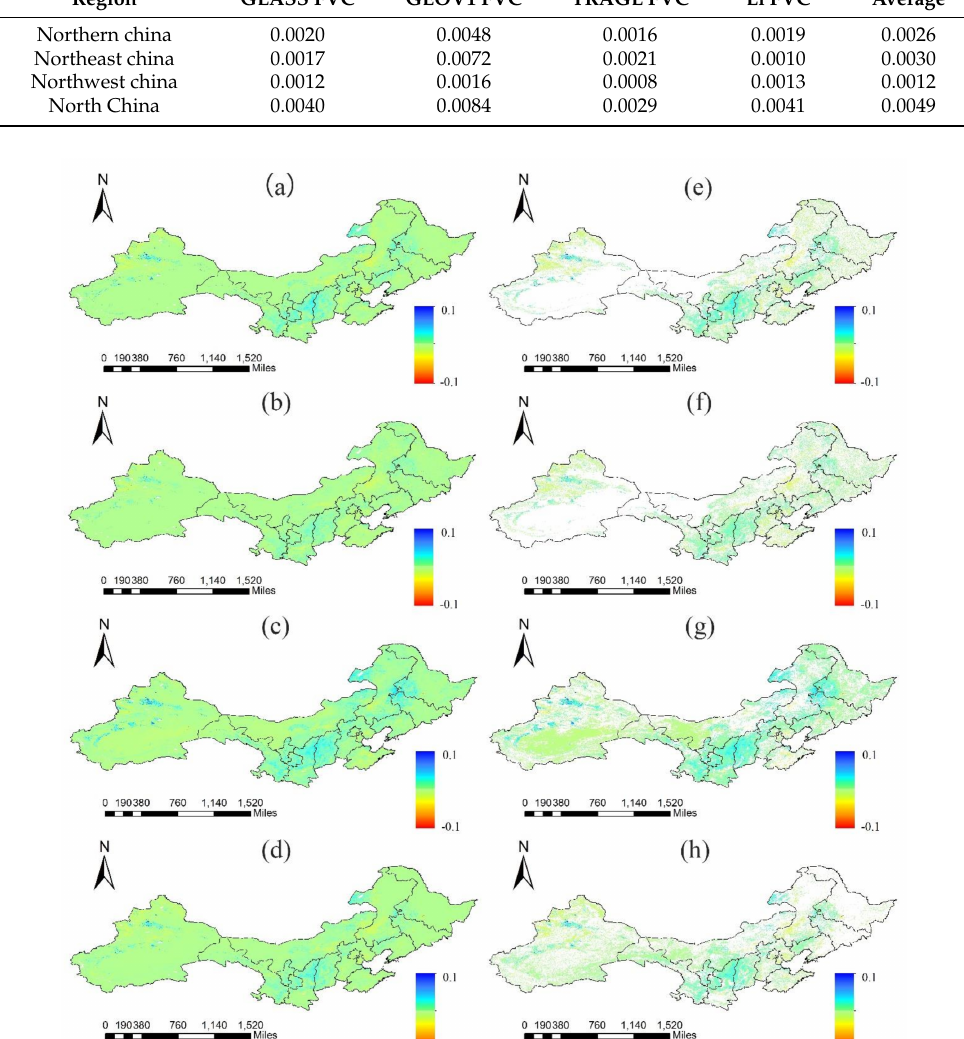
Figure 3. The temporal trends of annual maximum FVC in northern China during the periods 2001–2012. Left column is the temporal trends of ( a ) GLASS FVC, ( b ) TRAGL FVC, ( c ) GEOV1 FVC, ( d ) Li FVC. Right column is the temporal trends of annual maximum FVC that passed the significant test in northern China during the periods 2001–2012. ( e ) GLASS FVC; ( f ) TRAGL FVC; ( g ) GEOV1 FVC; ( h ) Li